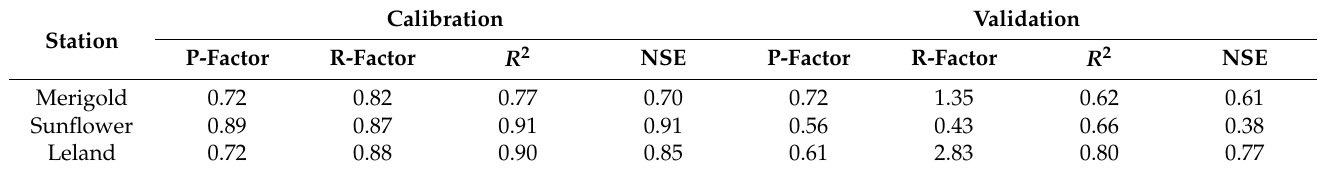
Table 5. Evaluation of model performance during TSS load calibration and validation.